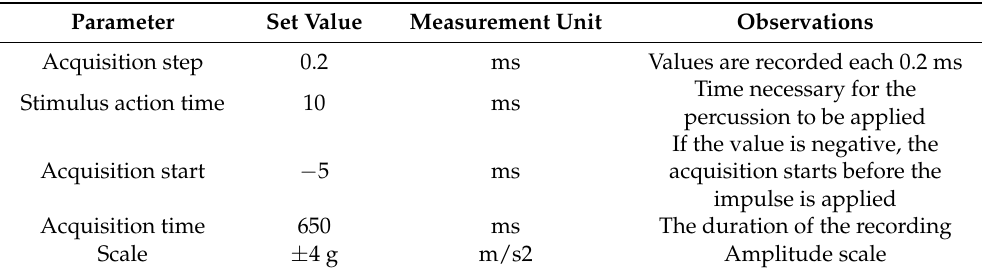
Table 2. Parameters used for the present DI experiment.